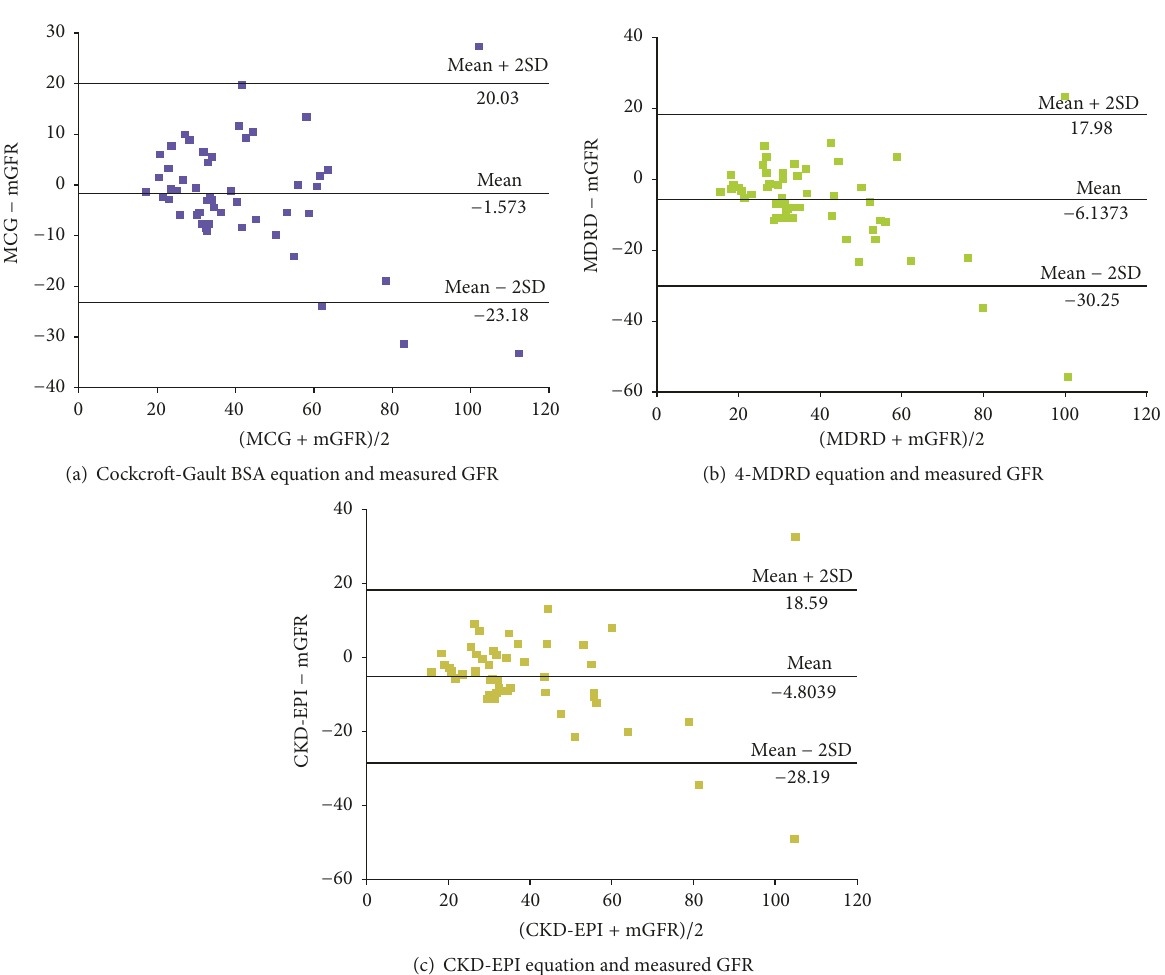
∗ Significantly correlating with 𝑝 < 0.001 .